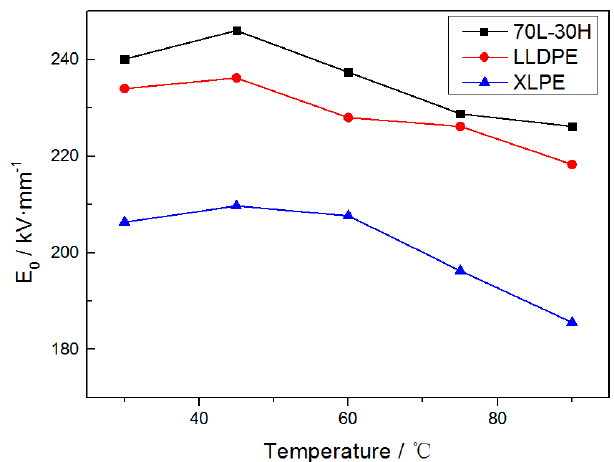
Figure 2. The E 0 of 70 L-30 H, linear low density polyethylene (LLDPE) and crosslinking polyethylene (XLPE) with temperature.